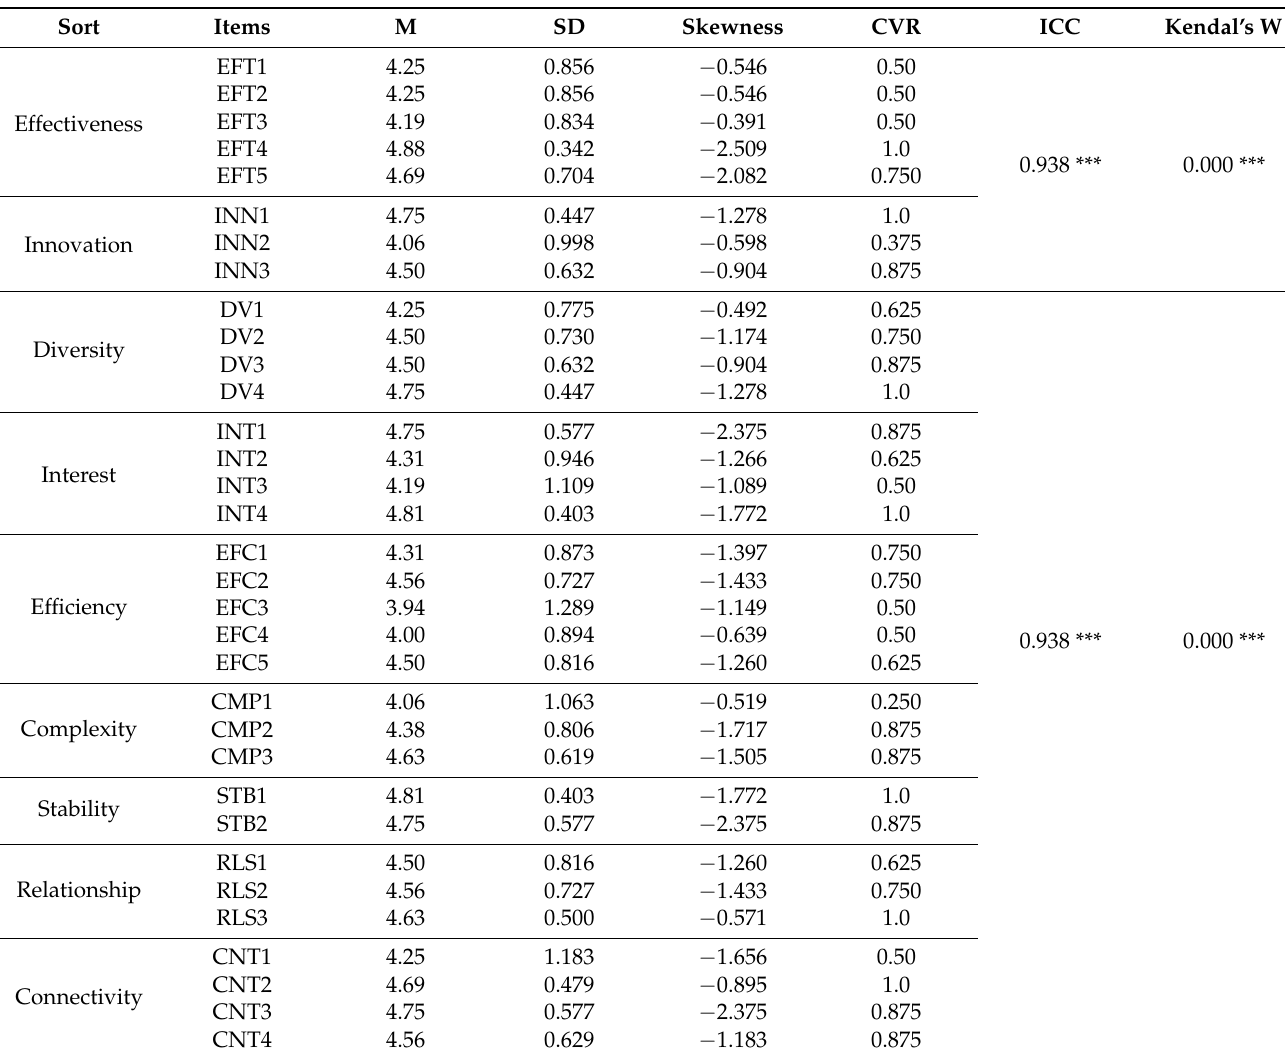
Table 5. Conformity and Validity Results on Outdoor Playground Design Criteria Development